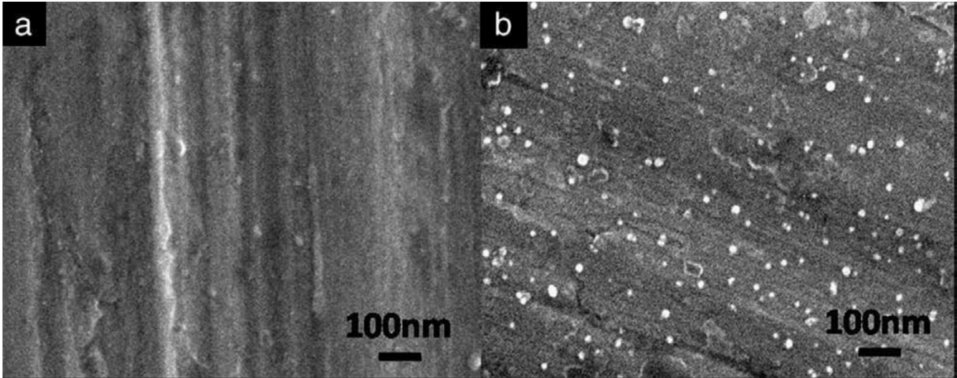
Figure 7. SEM images of the samples: ( a ) blank stainless steel sheet; and ( b ) AgNPs-stainless steel sheet obtained by Chen et al. (Reproduced from [90], published by Elsevier, 2010.).